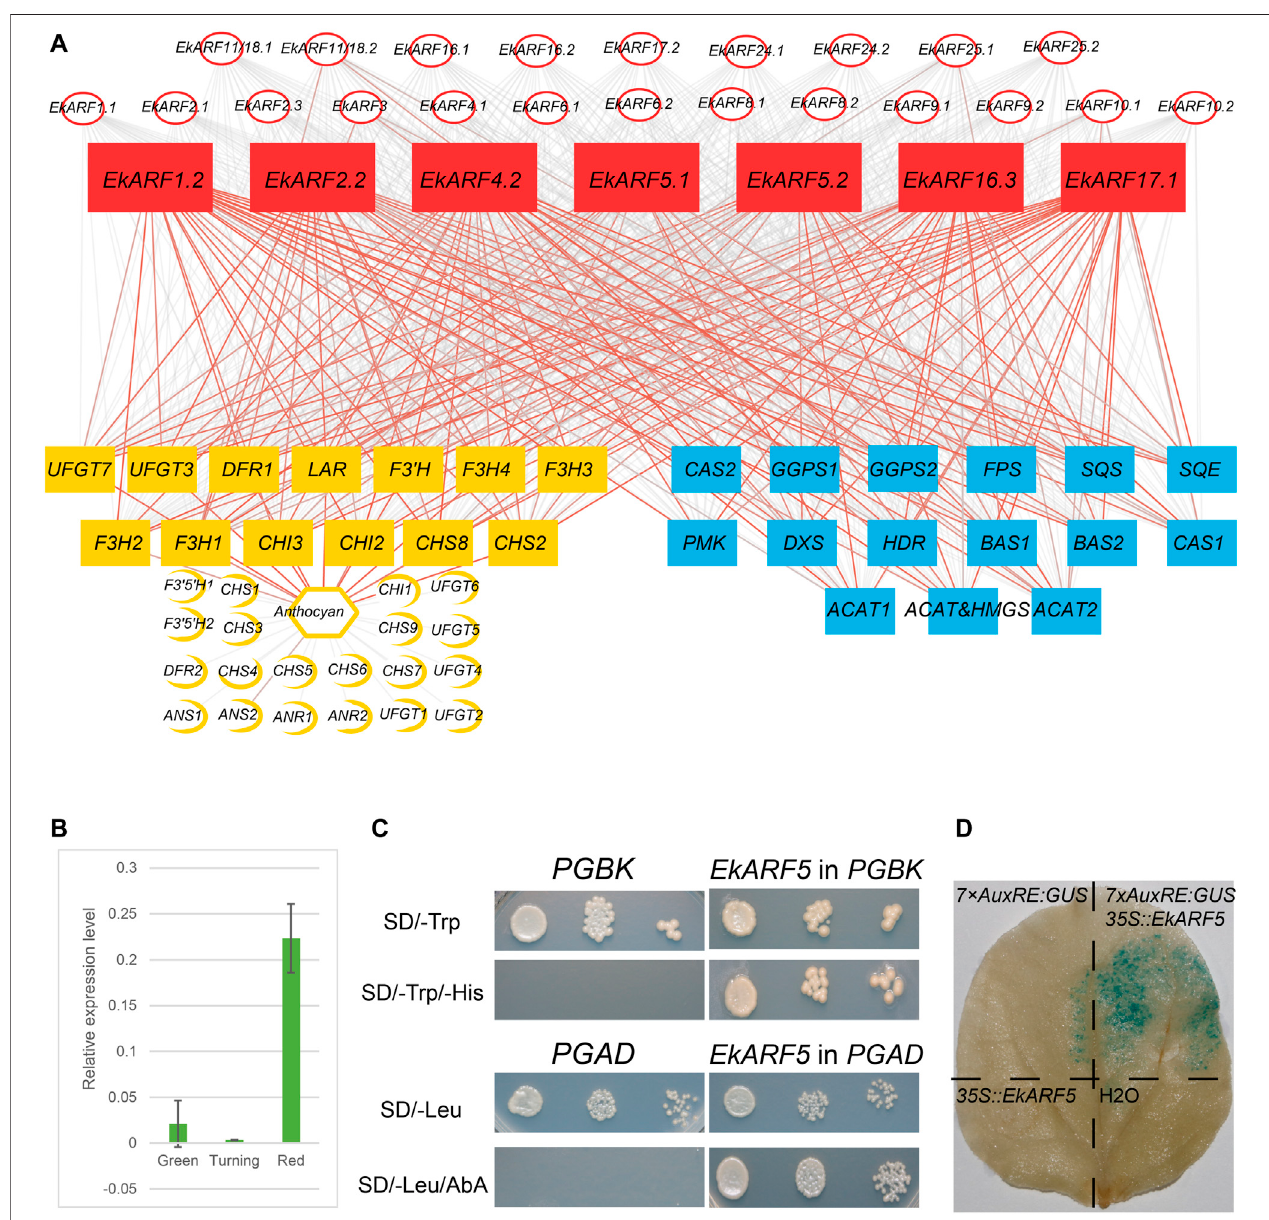
FIGURE7| Correlationanalysisbetweenanthocyanincontentsand EkARF expression,andtriterpenoidcontentsand EkARF expression. (A) Red, EkARFs ;yellow, anthocyanins; blue, triterpenoids. The gray lines indicate weak correlation, and red lines indicate strong correlation. (B) RT-qPCR results. (C) Yeast one-hybrid analysis results. (D) Results from GUS